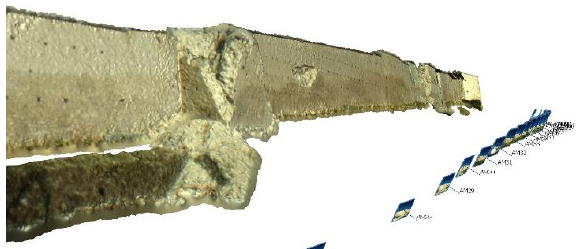
Figure 5. 3D Reconstruction of Norcia historic urban walls